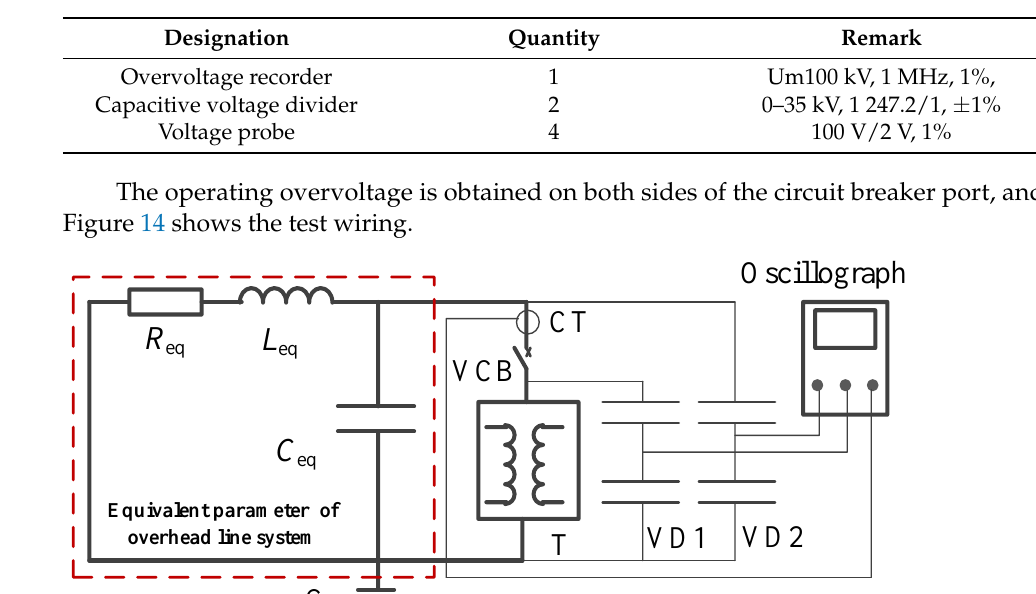
Figure 14. Test circuit wiring (In the figure VD1 and VD2 is voltage divider, T is transformer with no-load). Testing connection diagram on field is shown in Figure 15.